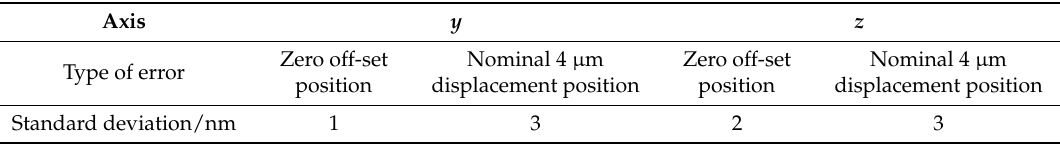
Table 4. Repeatability of the flexible mode for the x and y directions. The measurement was repeated ten times for each displacement (nominal displacement is 4 µ